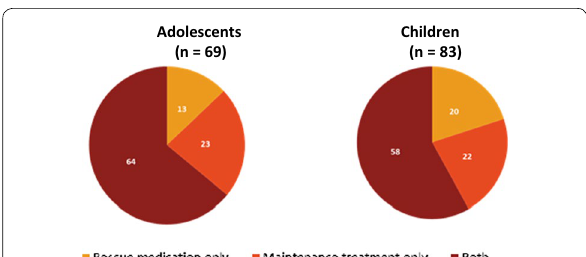
Fig. 3 Proportion (%) of adolescents and children with severe persistent asthma on maintenance treatment, as needed